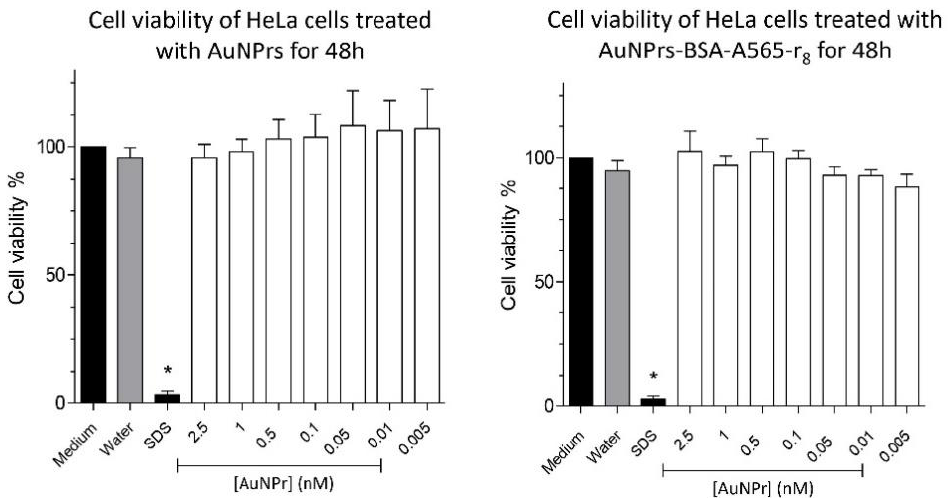
Figure 5. Effect of AuNPrs and AuNPr-BSA-r 8 incubated for 24 h on cell viability of HeLa cells at 48 h. The average values for n = 4 experiments are shown with error bars representing the SEM. * Significant difference according to Tukey’s test p < 0.05 compared to medium control.